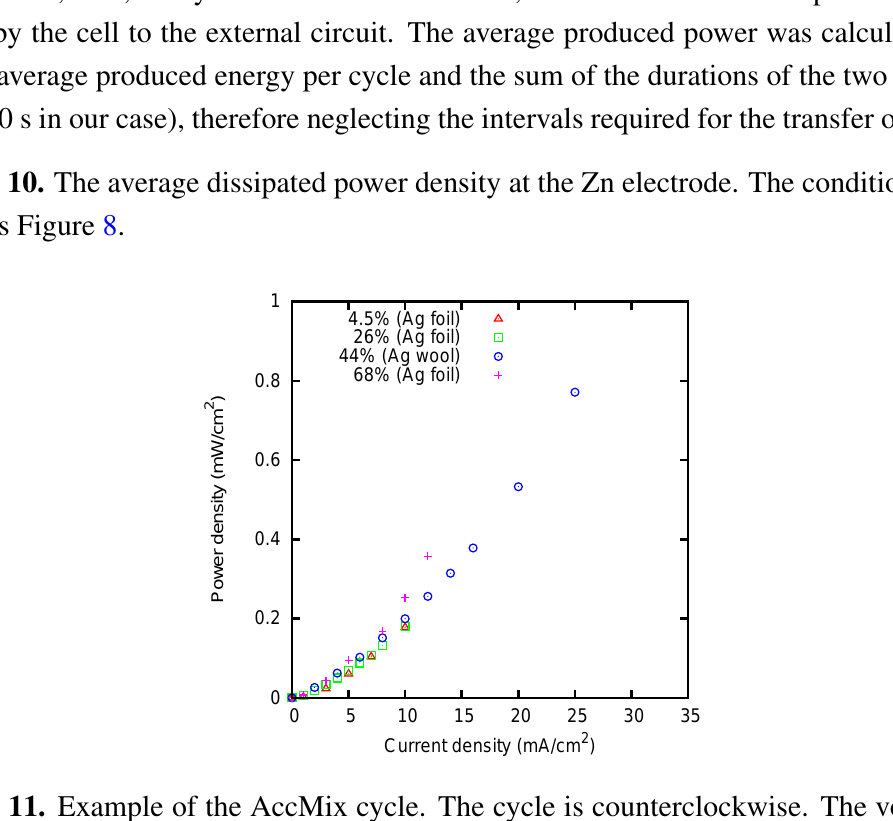
Figure 11. Example of the AccMix cycle. The cycle is counterclockwise. The voltage rise is approximately 160 mV. The overvoltage, which reduces the cycle’s surface, results from the flowing current of 4